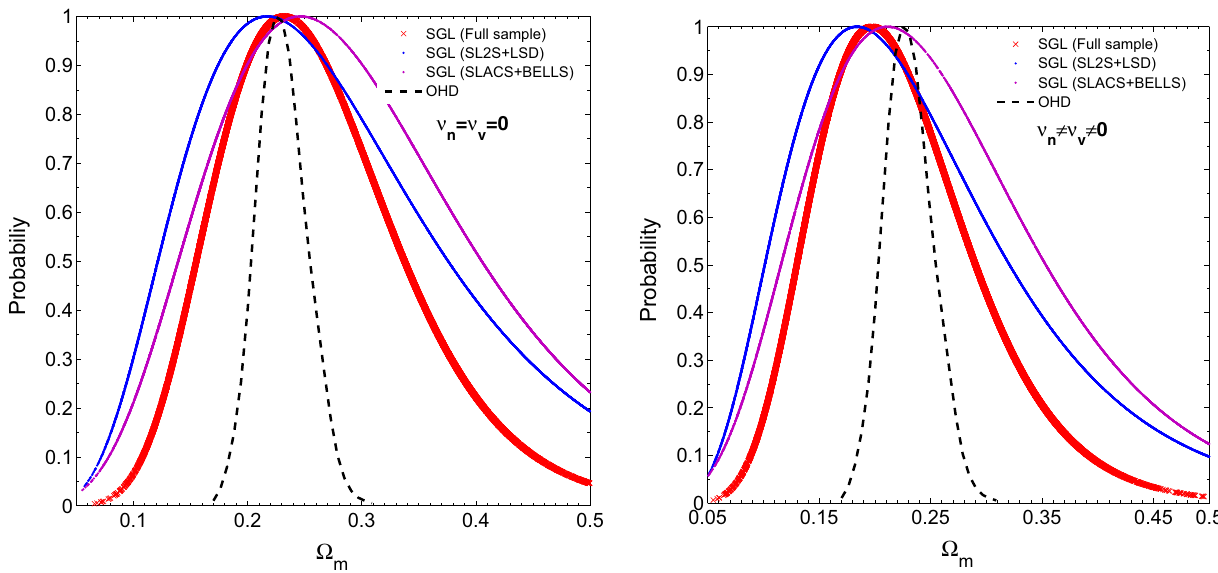
Fig. 3 Constraints on the matter density parameter in the flat DGP model, which are obtained from the lens redshift distribution of current SGL systems with and without the redshift evolution of lensing galaxies. Fitting results from recent observational Hubble parameter data (OHD) are also added for